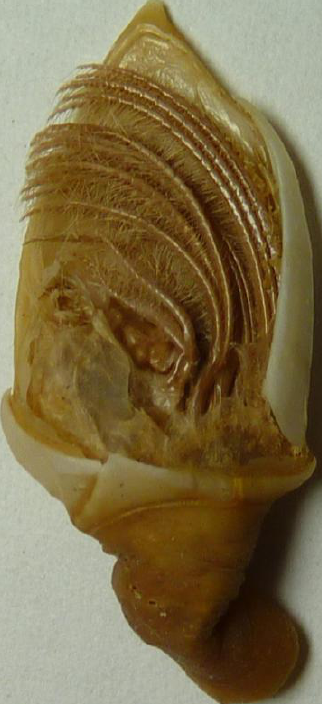
Figure 2. The stalked barnacle Smilium zancleanum (Seguenza, 1876), with plates on the right-hand side removed to show the cirri. The resemblance to a bird‘s wing is evident, although it clearly lacks a bird‘s head. Length of barnacle 30mm